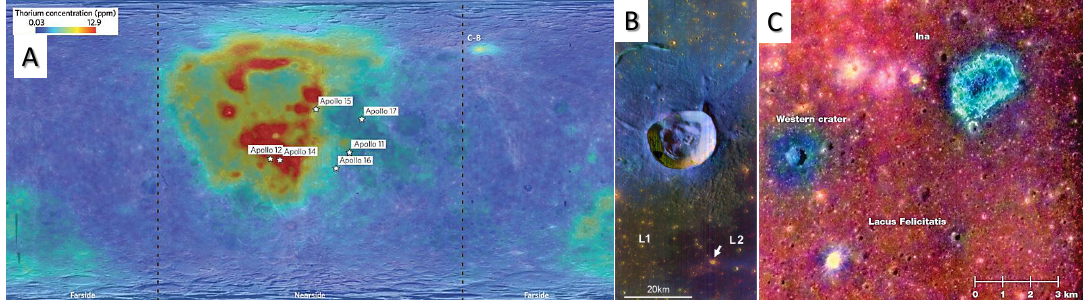
Figure 3. Compositional and age variability in lunar basalts. ( A ) Large variations in Thorium concentrations (a proxy for Potassium, Rare Earth Elements and Phosphorus (KREEP)) between near and far side, as observed by lunar prospector observations (Source: [66], NASA) . ( B ) Very young basalts (~1 b.y.) around Lichtenberg crater (Source: [67]) . ( C ) Geologic (and spectral) freshness of Ina D structure was suggested to be an evidence for recent outgassing from the lunar interior (Source: [64])